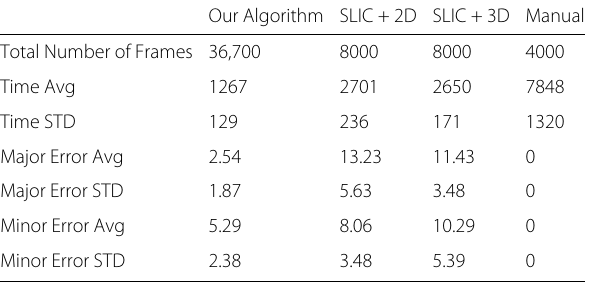
Table 2 A summary of tracking results Our Algorithm SLIC + 2D SLIC + 3D